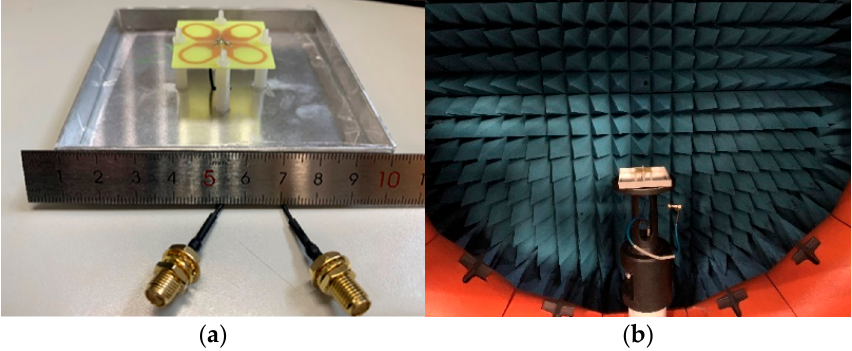
Figure 9. The prototype and the measured environment of the proposed antenna. ( a ) The prototype, ( b ) the measured environment of the proposed antenna.